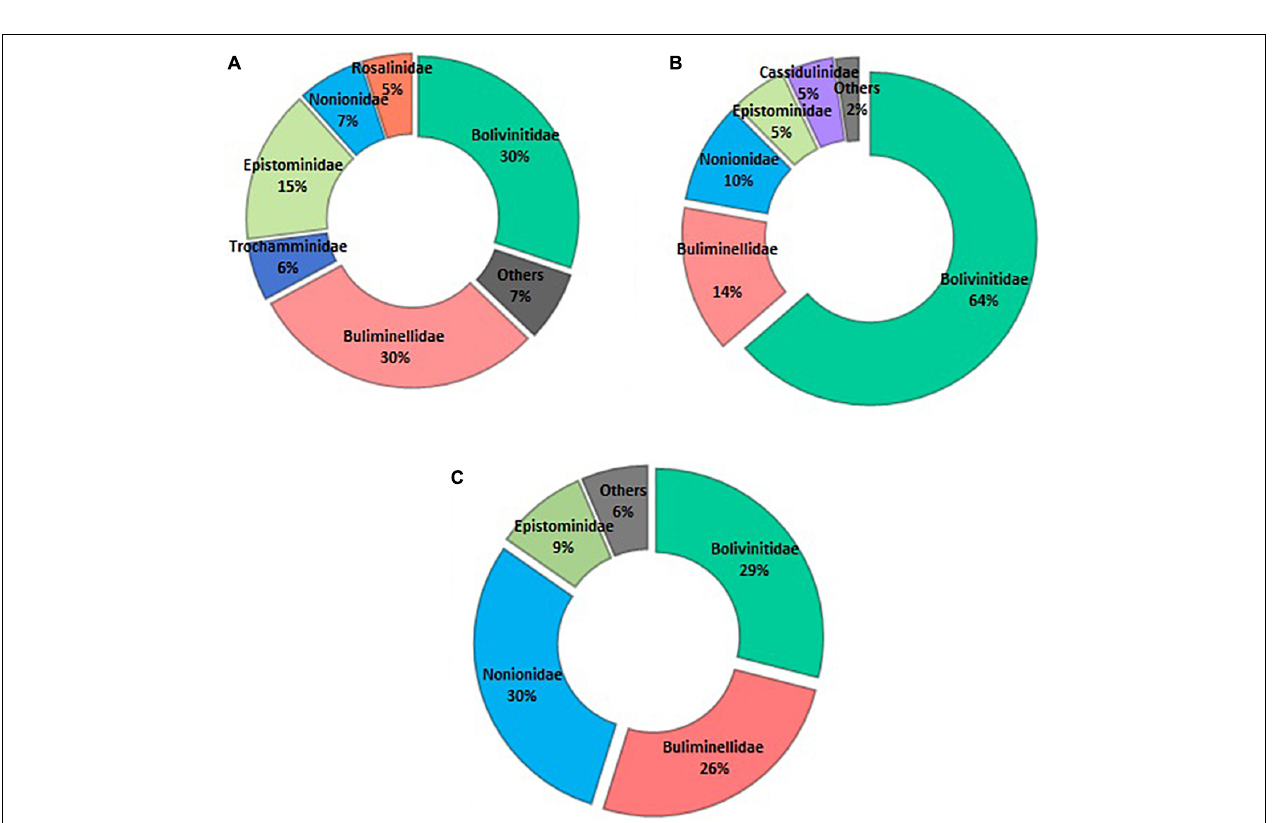
FIGURE 3 | Representatives of the order Rotaliida with the greatest number of species on a spatial and vertical distribution: (A) Fursenkoina sp.; (B) Nonionella ; (C) Valvulineria , umbilical view; (D) Valvulineria , whorl view; (E) Cassidulina ; (F–H) Bolivina .